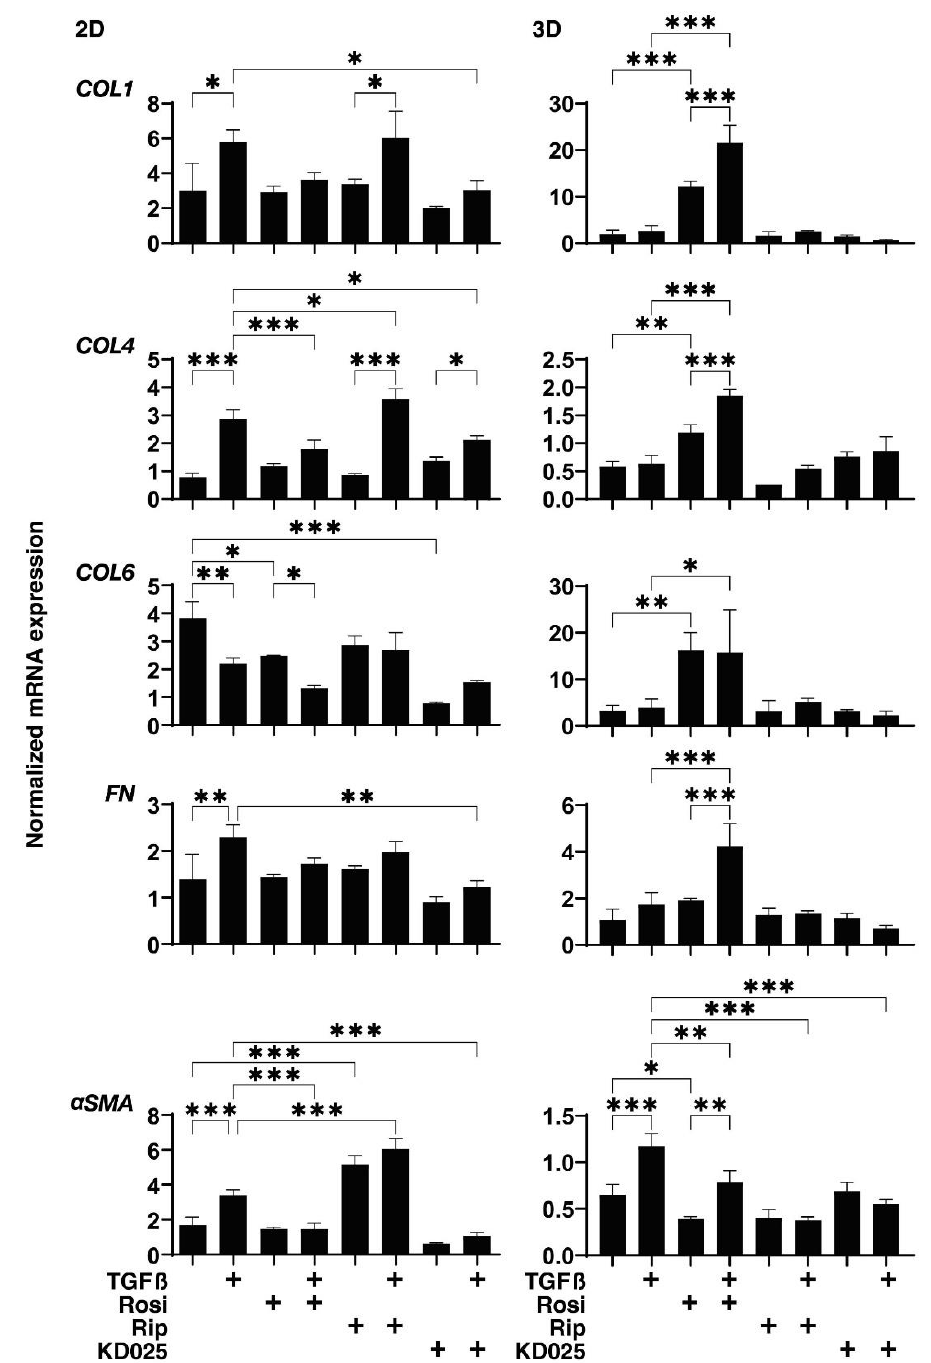
Figure 4. mRNA expression of ECMs of 2D and 3D cultured HconF cells in the absence or presence of TGF β 2 and/or rosiglitazone, ripasudil or KD025. The following eight experimental groups included: (1) control for (2), (2) treated with 5 ng/mL TGF- β 2 (TGF β ), (3) treated with 10 µ M rosiglitazone (Rosi); control for (4), (4) treated with TGF β and Rosi, (5) treated with 50 µ M ripasudil (Rip); control for (6), (6) treated with TGF β and Rip, (7) treated with 50 µ M KD025; control for (8) and (8) treated with TGF β and KD025. Each 2D and 3D HconF cells at day 6 was subjected to qPCR analysis to estimate the expression of mRNA in ECMs ( COL1, COL4, COL6 or FN ). All experiments were performed in duplicate using fresh preparations consisting of a single well out of 12 wells of the culture dish (2D) or 16 organoids each. Data are presented as the arithmetic mean ± the standard error of the mean (SEM). * p < 0.05,** p < 0.01, *** p < 0.005 (ANOVA followed by a Tukey’s multiple comparison test).